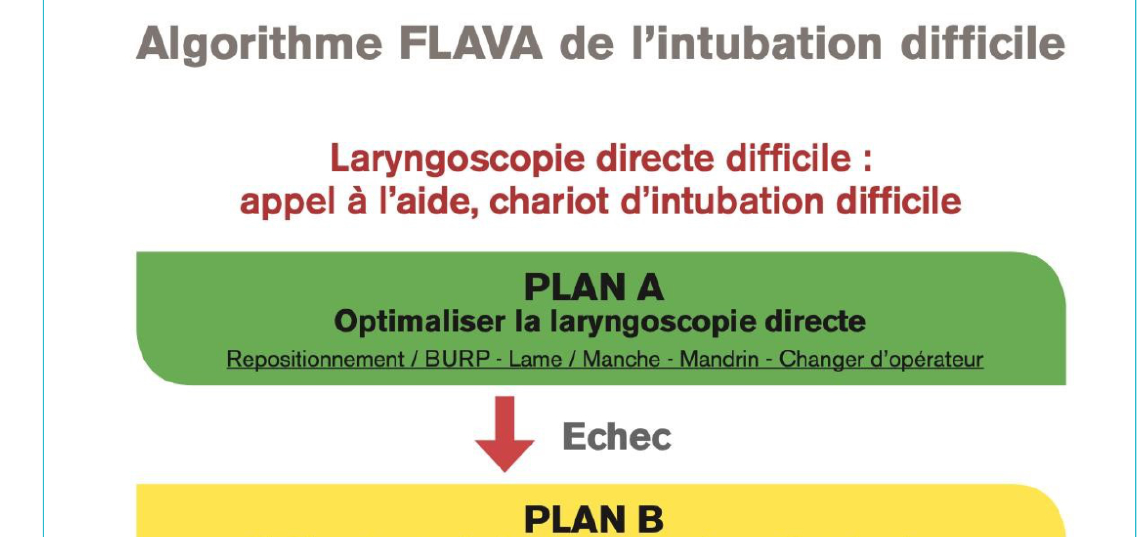
Figure S1: The 2013 FLAVA algorithm for unexpected difficult tracheal intubation (French